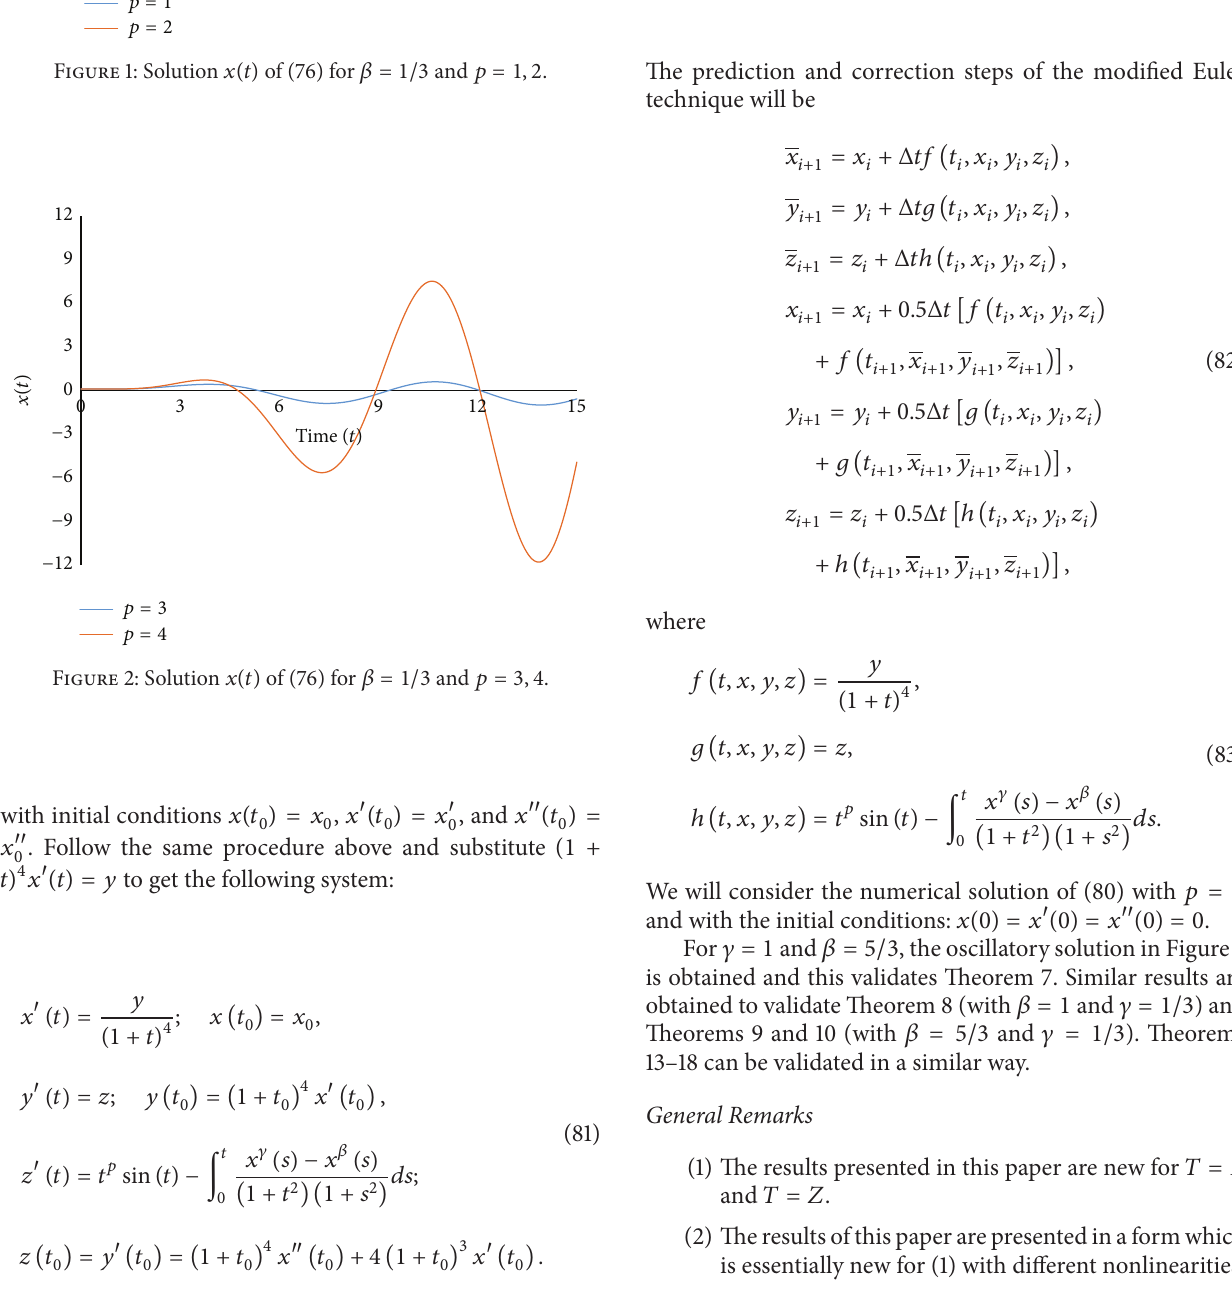
Figure 3: Solution 𝑥(𝑡) of (80) for 𝛾 = 1 and 𝛽 = 5/3 and 𝑝 = 6 .